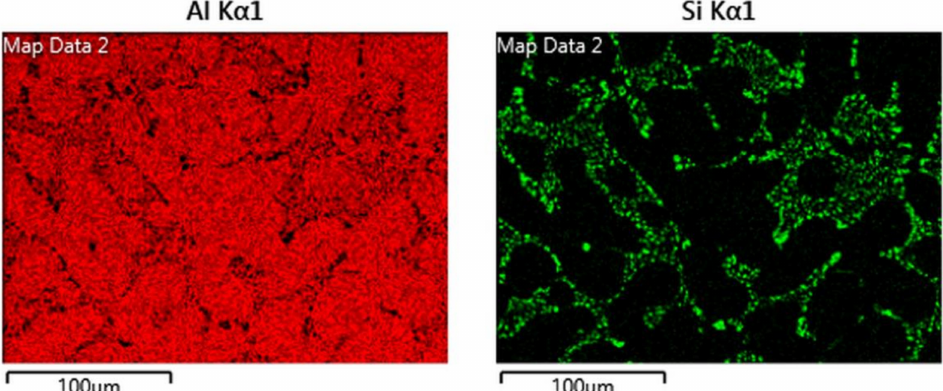
Figure 2. An energy dispersive X-ray spectrometer (EDS) map showing the distribution of aluminium and silicon in the tested A356-T7 + 0.5 wt.% Cu